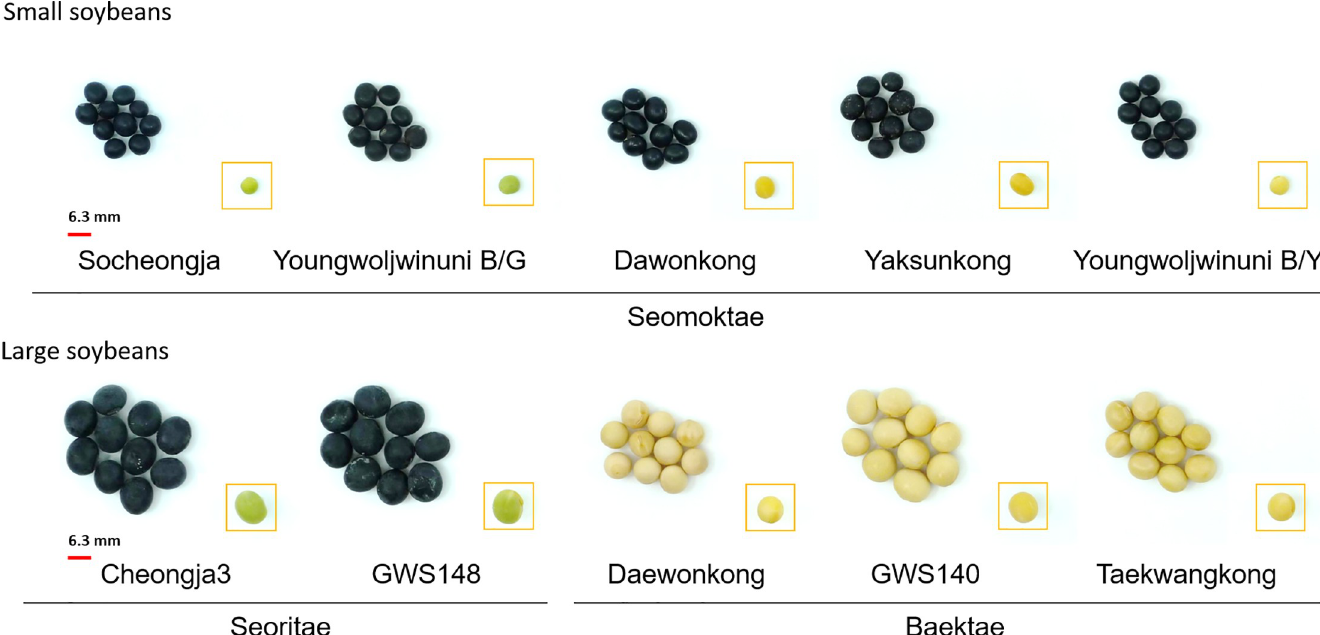
Fig 1. The visual characteristic of small-seeded and large-seeded soybeans. The boxes represent cotyledons of soybeans with the seed coat removed. Small-seeded soybeans: Socheongja (black seed coat / green cotyledon); Youngwoljwinuni B/G (black / green); Dawonkong (black / yellow); Yaksunkong (black / yellow); Youngwoljwinuni B/Y (black / yellow). Large-seeded soybeans: Cheongja3 (black / green); GWS148 (black / green); Daewonkong (yellow / yellow); GWS140 (yellow / yellow); Taekwangkong (yellow / yellow).